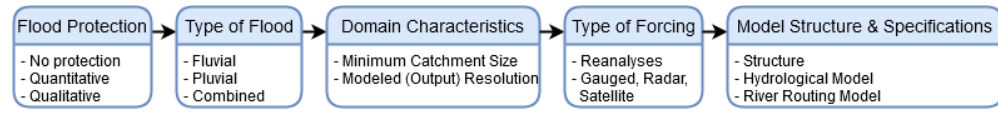
Figure 5. Flowchart describing practitioners’ flood hazard map selection